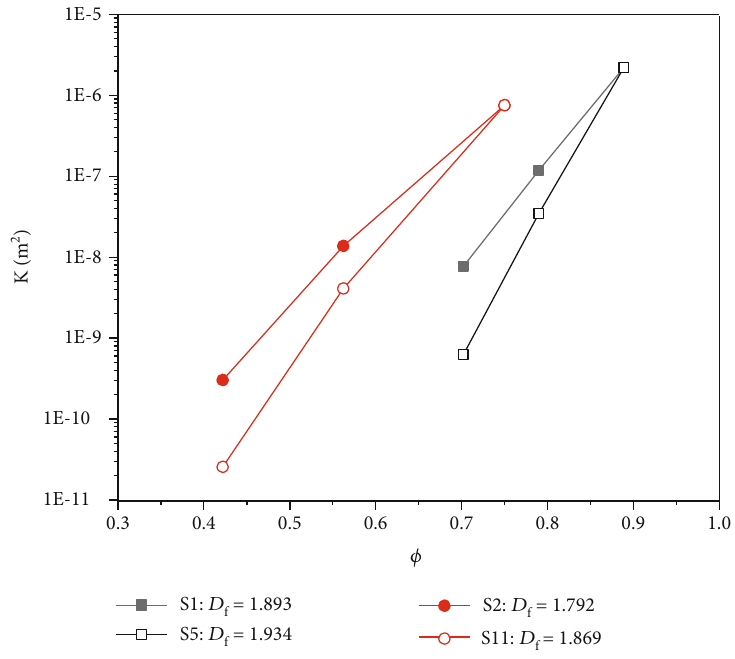
Figure 4: The e ff ect of pore fractal dimension on the permeability of isotropic porous